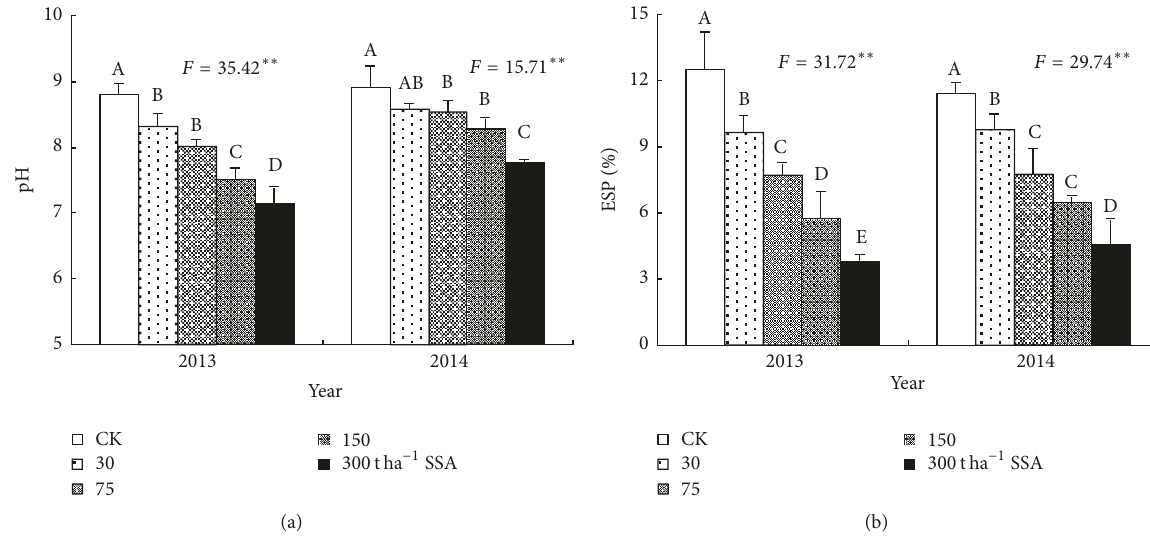
Figure 2: Effects of sewage sludge amendment (SSA) combined with green manuring on pH (a) and ESP (b) of coastal mudflat salt-soil. Vertical bars indicate standard deviations of the means. Columns with different letters show significant difference between sewage sludge amendment rates at 𝑝 < 0.05 by LSD’s multiple range test. Values of 𝐹 are the 𝐹 test in ANOVA; ∗∗ 𝑝 < 0.01 . pH, hydrogen ion concentration; ESP, exchangeable sodium percentage.